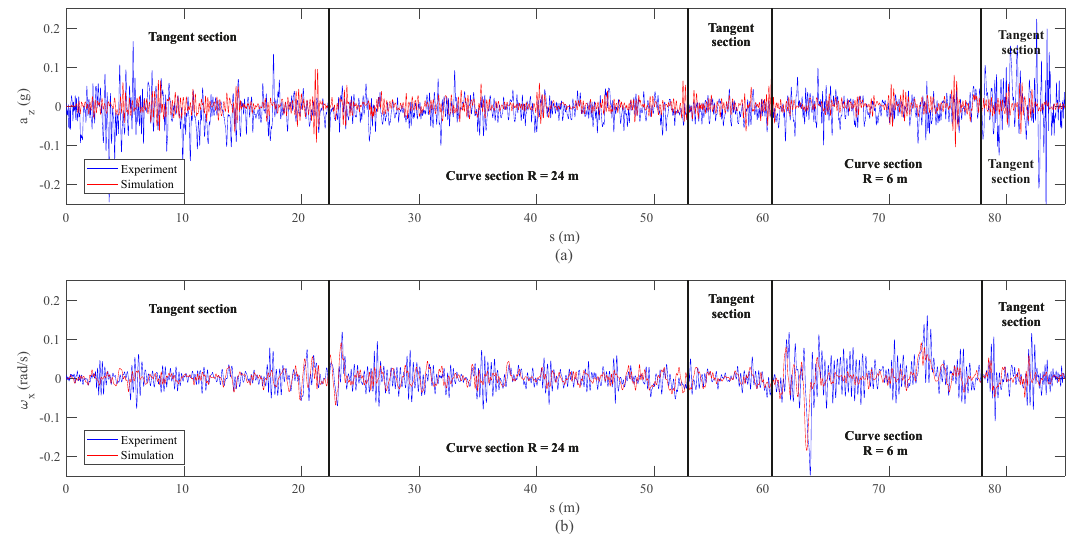
Figure 15. Vertical acceleration ( a ) and roll angular velocity ( b ) data from inertial sensors on the bogie frame.